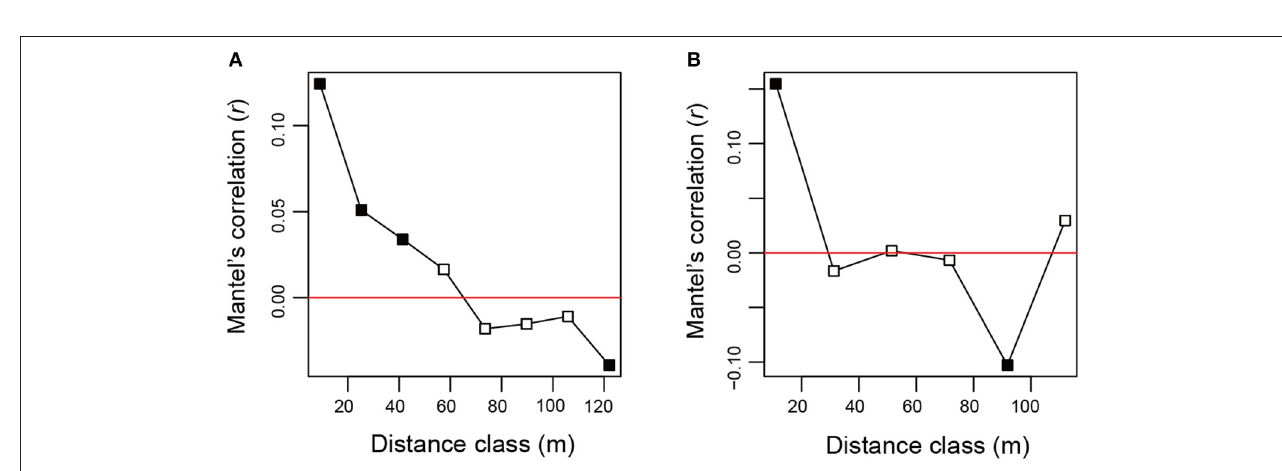
FIGURE 4 | Spatial autocorrelation of fungal community structure. (A) Mantel’s correlogram analysis of Chamaecyparis samples. A positive value indicated by filled squares represents statistically significant spatial autocorrelation at the spatial distance class ( α = 0.05). (B) Mantel’s correlogram analysis of Pinus samples.